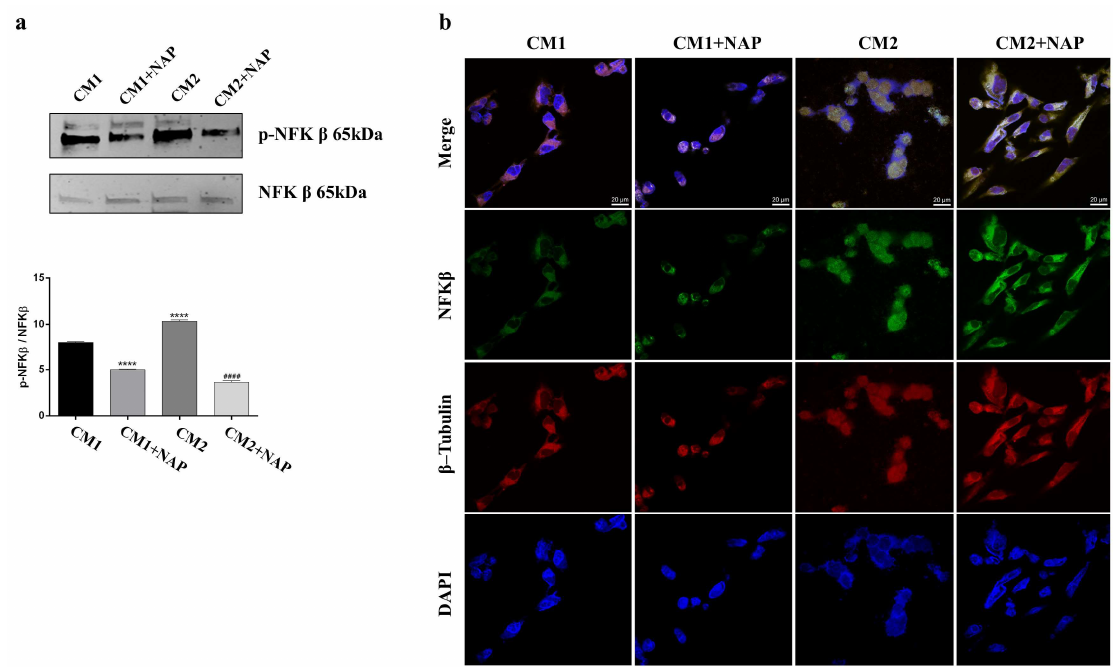
Figure 3. Effect of NAP treatment on the NF- κ B activation in UV-B-irradiated corneal epithelial cells. ( a ) Representative immunoblots of p- NF- κ B expression in SIRC cells cultured in normal condition (CM1) or with NAP (10 nM) (CM1 + NAP) or cultured with CM2 alone or with NAP (CM2+NAP). The bar graph shows a quantitative analysis of signals obtained by immunoblots resulting from three independent experiments. Data represent means ± SEM. (**** p < 0.0001 vs. CM1; #### p < 0.0001 vs. CM2). ( b ) Representative photomicrographs show NF- κ B expression (red) and β -tubulin (green) in SIRC cells cultured in either normal condition (CM1) or with NAP (10 nM) (CM1 + NAP), or cultured with either CM2 alone or with NAP (CM2 + NAP). Photomicrographs are representative results of fields taken randomly from each slide. Scale bar, 20 µ